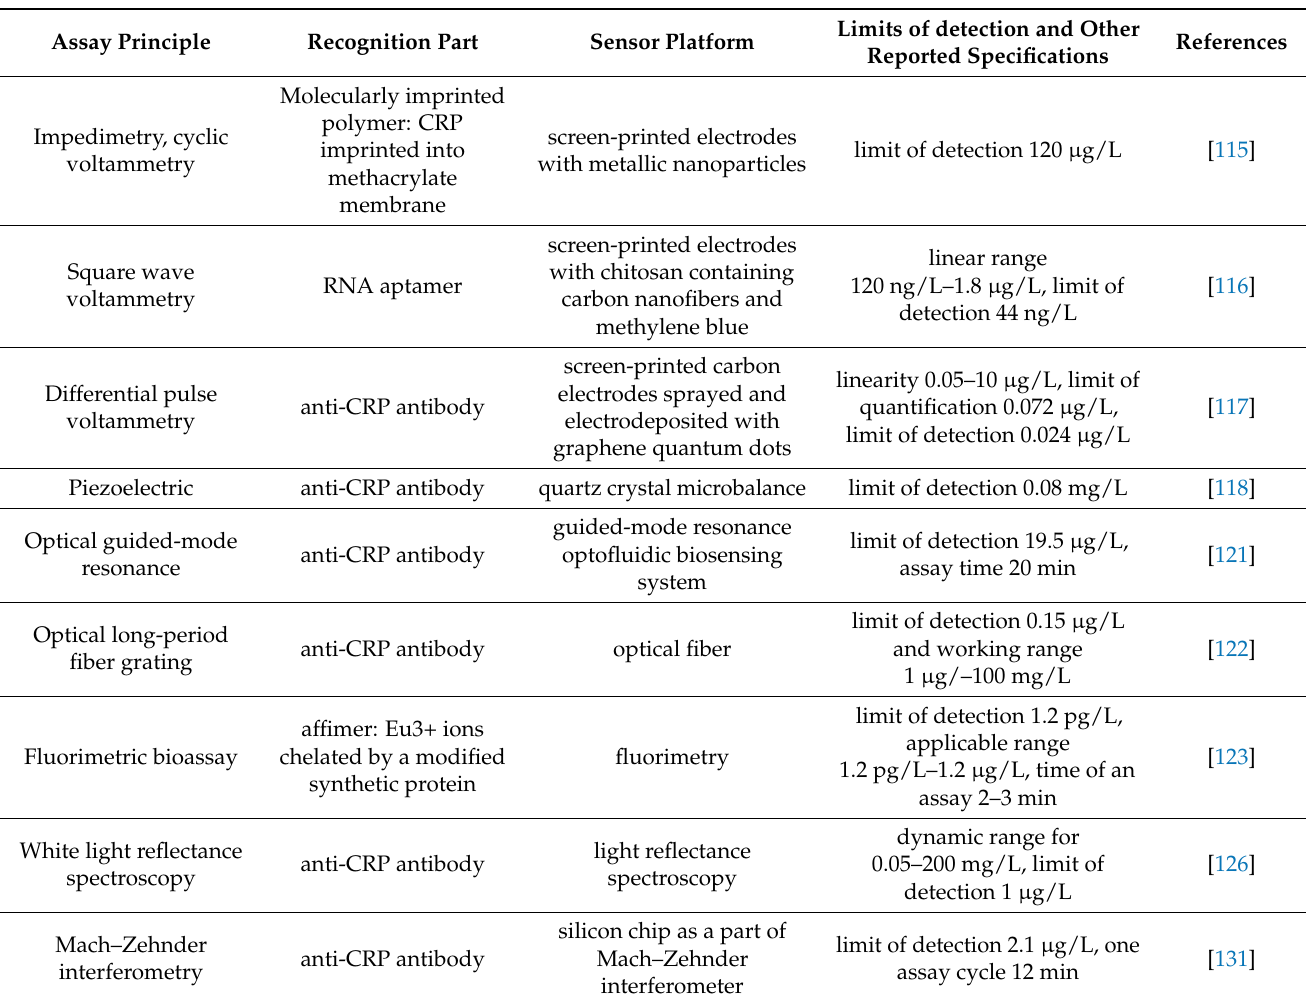
Table 3. Survey of biosensors and bioassays for CRP